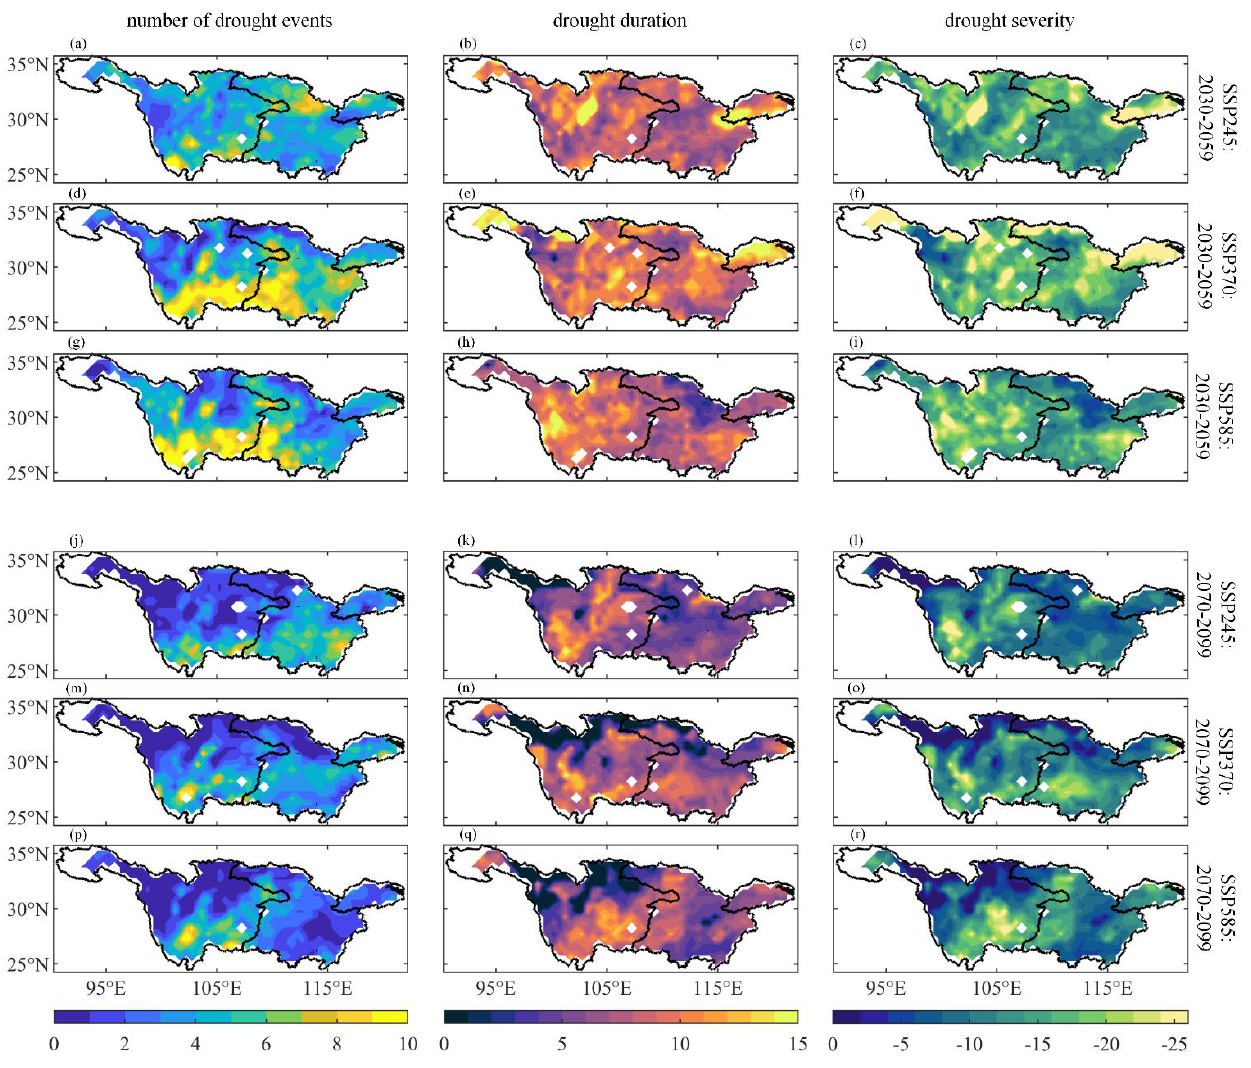
Figure 7. Spatial distribution of the number of drought events ( a , d , g , j , m , p ), average duration ( b , e , h , k , n , q ), and average severity ( c , f , i , l , o , r ) in the 12-month scale in the Yangtze River basin from 2030–2059 ( a – i ) and 2070–2099 ( j – r ) under the three scenarios of SSP245 ( a – c , j – l ), SSP370 ( d – f , m – o ), and SSP585 ( g – i , p – r ). Under different time scales and different scenarios, most of the probability distribu- tions show the trend that the average value moves in the positive direction and the peak value decreases, which means that the Yangtze River basin will become wetter in the fu- ture (Figure 8). The magnitude of the positive shift of the probability mean increases with the increase of the time scale. The probability mean of the 1-month, 3-month, 6-month, and 12-month scales will increase from 0 to 0.09, 0.14, 0.19, and 0.24 in the near future, and 0.26, 0.44, 0.59, and 0.80 in the far future, respectively. The probability of basic drought (SPI < −1 ) decreases as the time scale becomes larger in the future, unlike the reference period, where it becomes larger with a larger time scale.